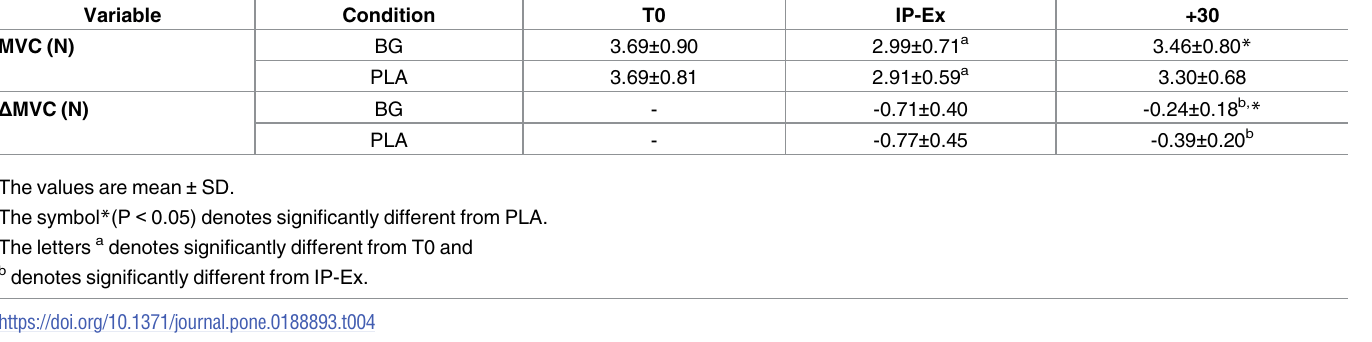
Table 4. Absolute values of maximal voluntary contraction (MVC) and difference ( Δ MVC) from baseline (T0) immediately after exercise(IP-Ex) and 30 minutes of recovery(+30) after beetroot-based nutritional gel (BG) and nitrate-depleted gel (PLA) intervention.